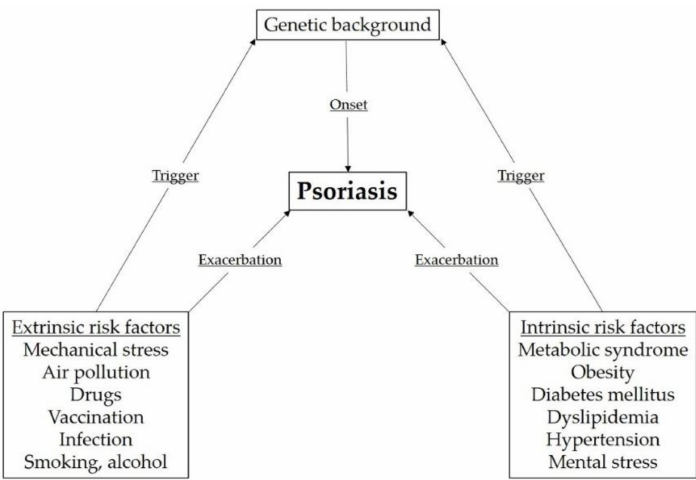
Figure 1. Risk factors for the onset and exacerbation of psoriasis. As shown in this figure, extrinsic and intrinsic factors are associated with the onset and exacerbation of